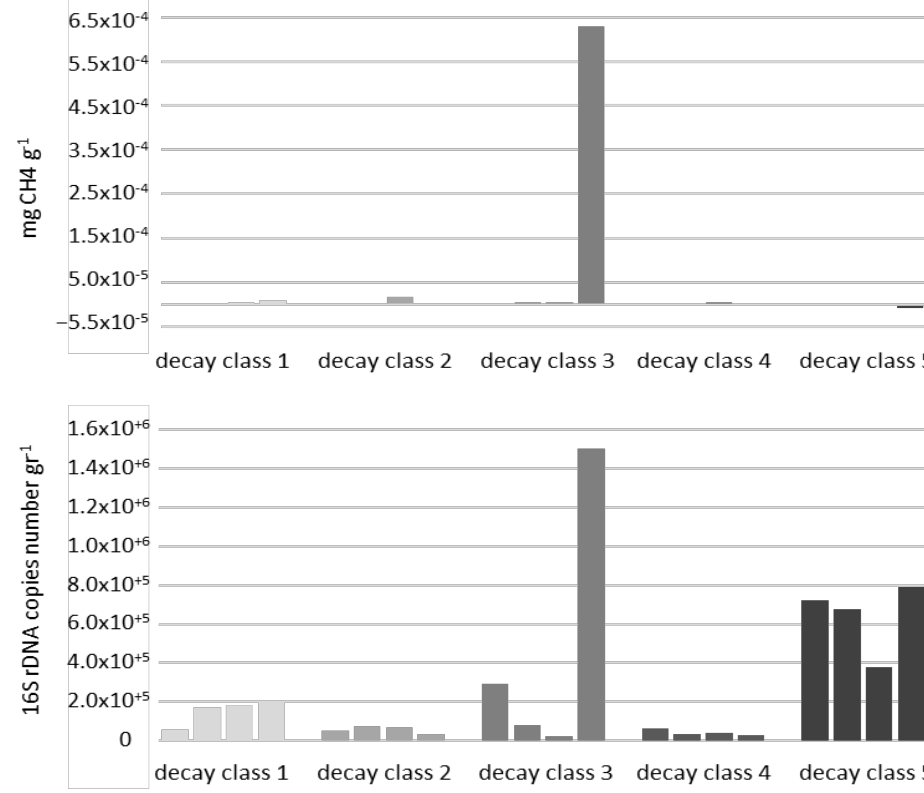
Figure 6. Maximum values of CH 4 production and number of methanogenic archaeal 16S rDNA gene copies resulting from a mesocosm experiment consisting of the cores of five different